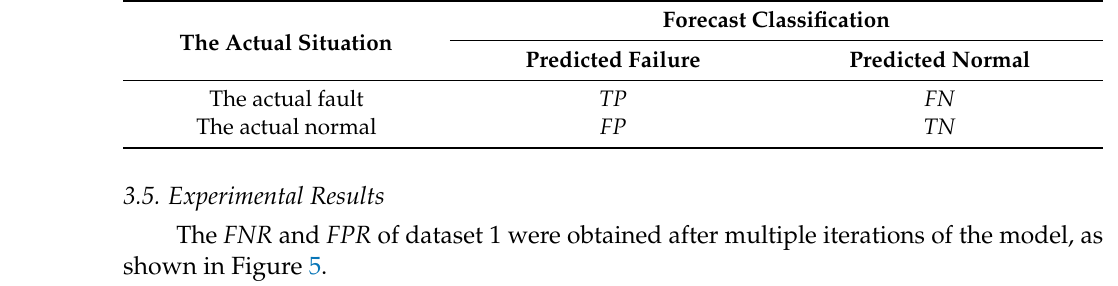
Table 4. Confusion matrix of classification results.